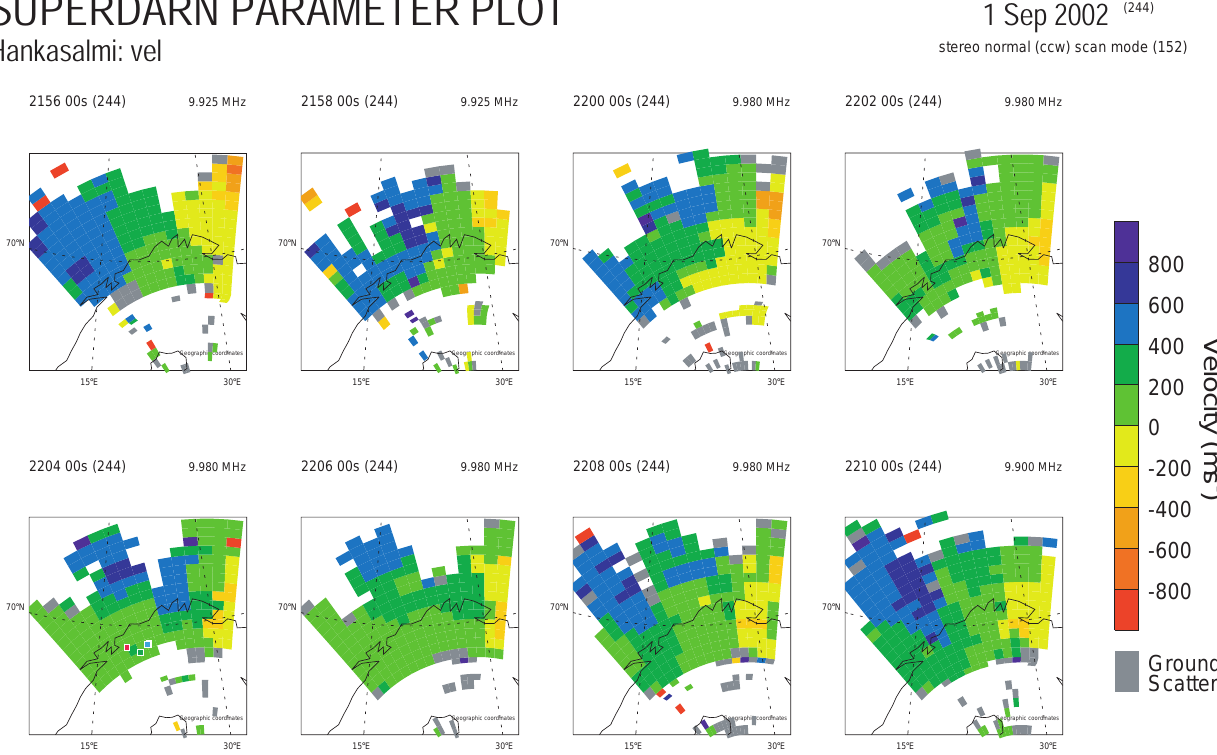
Fig. 10. Two-dimensional maps of the CUTLASS Finland flow data over the interval 21:56-22:10 UT. Cluster footpoint location is indicated in the 22:04 plot.